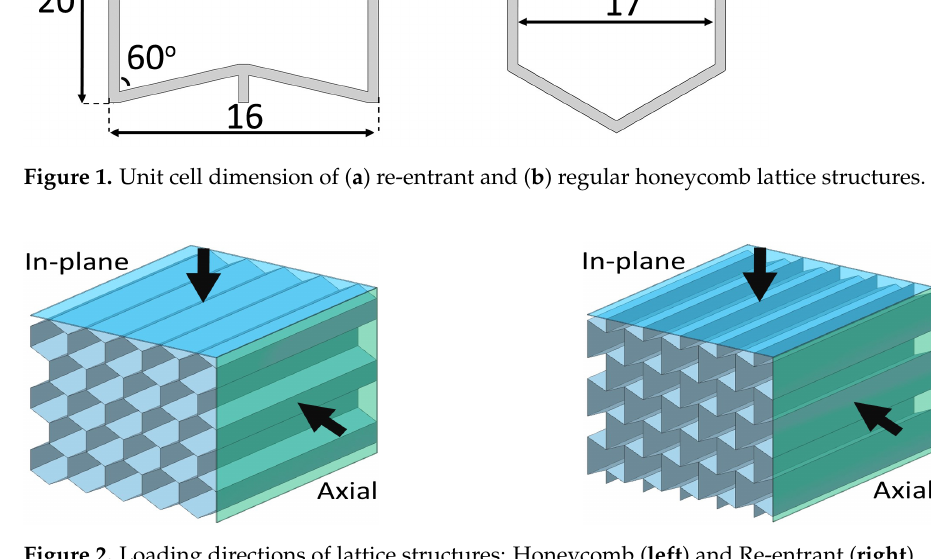
Figure 2. Loading directions of lattice structures: Honeycomb ( left ) and Re-entrant ( right